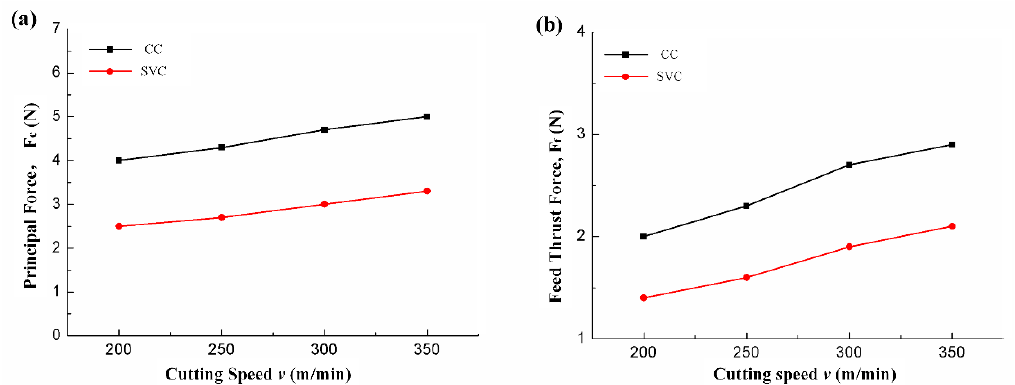
Figure 6. Average ( a ) principal and ( b ) feed thrust forces vs. cutting speed (feed rate, 0.005 mm/r; depth of cut, 0.025 mm).